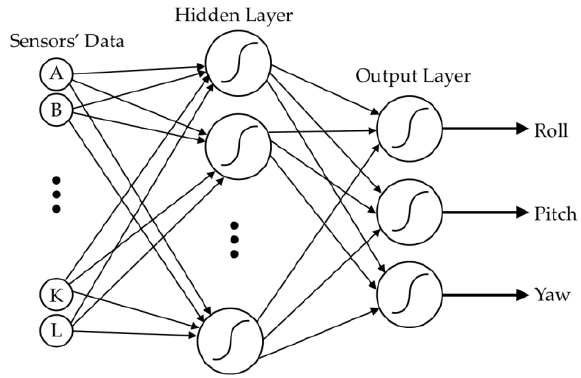
Figure 8. The block diagram of a neural network used to fuse inputs and map them to the outputs. There are 12 sensors’ signals and 3D angular position of the trunk as the inputs and outputs, respectively.